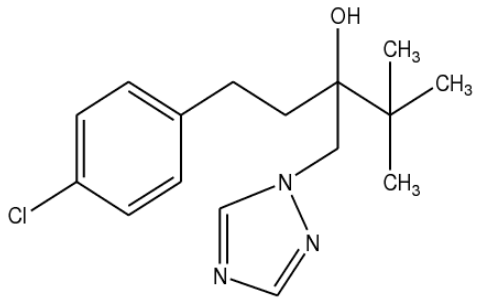
Figure 1. Structure of tebuconazole (TB).